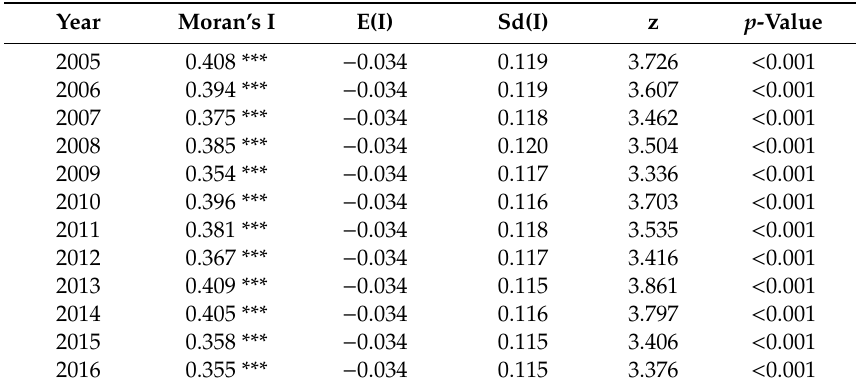
Table 3. Global Moran’s I of China’s